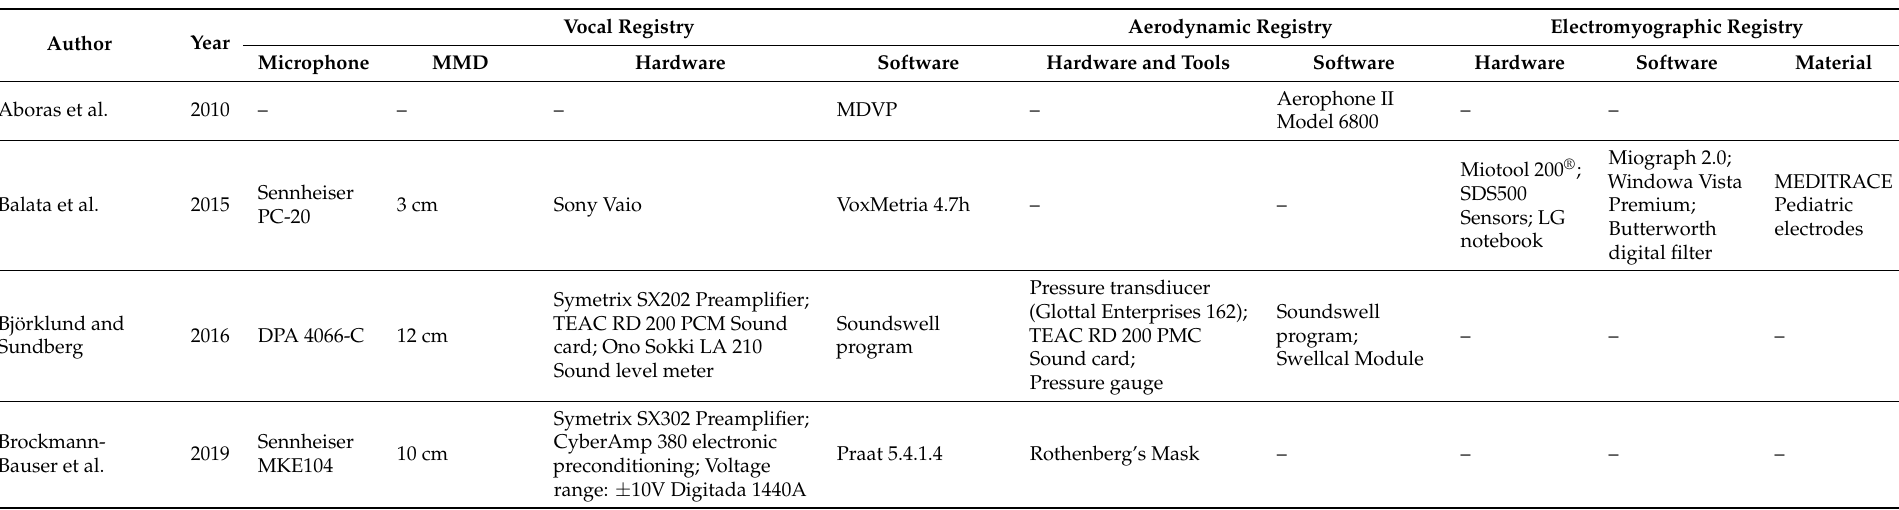
Table 3. Summary of the tools and materials used in the selected